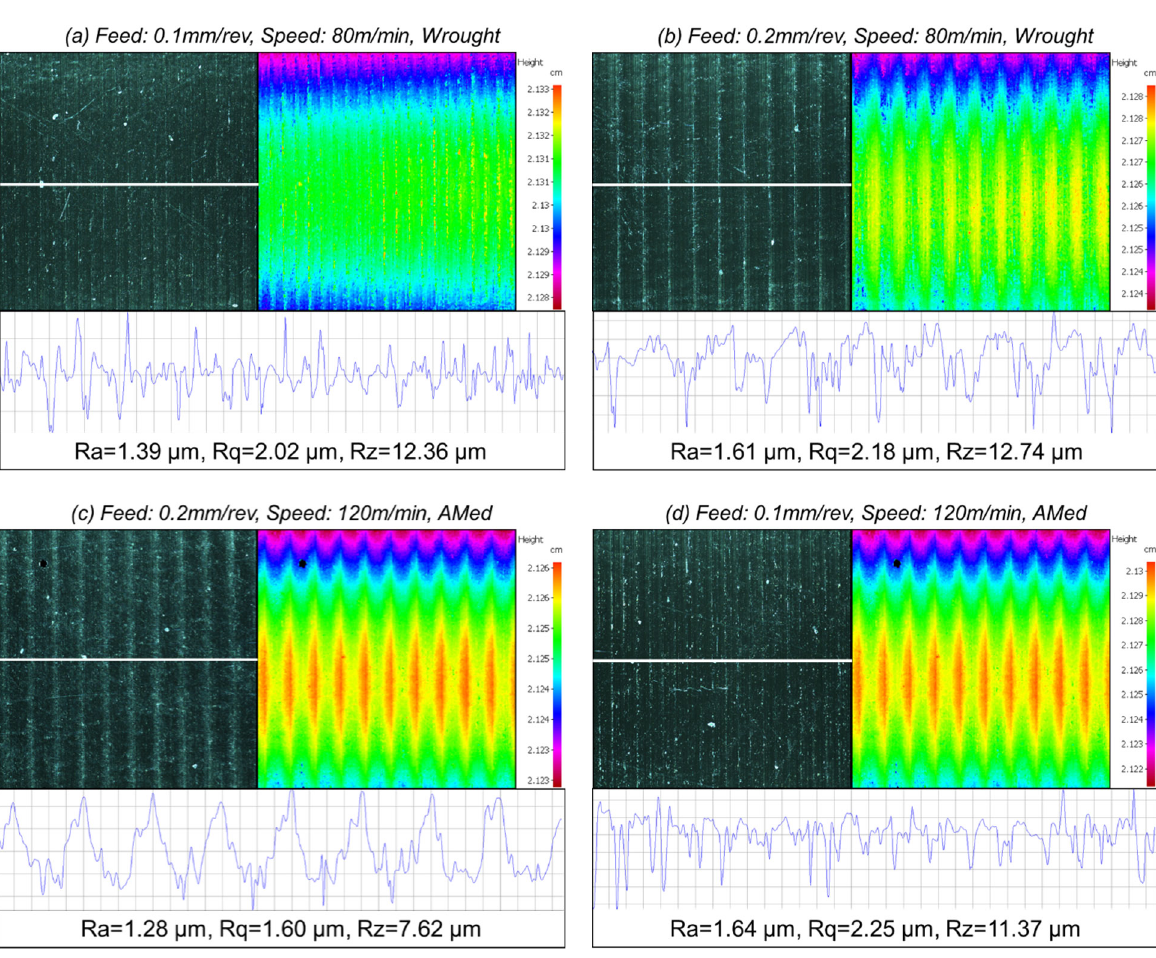
Figure 13. Profile of the machined surface of wrought Ti6Al4V at the cutting depth of 0.25 mm, ( a ) feed rate: 0.1 mm/rev, speed: 80 m/min; ( b ) feed rate: 0.2 mm/rev, speed: 80 m/min; ( c ) feed rate: 0.2 mm/rev, speed: 120 m/min; ( d ) feed rate: 0.1 mm/rev, speed: 120 m/min.